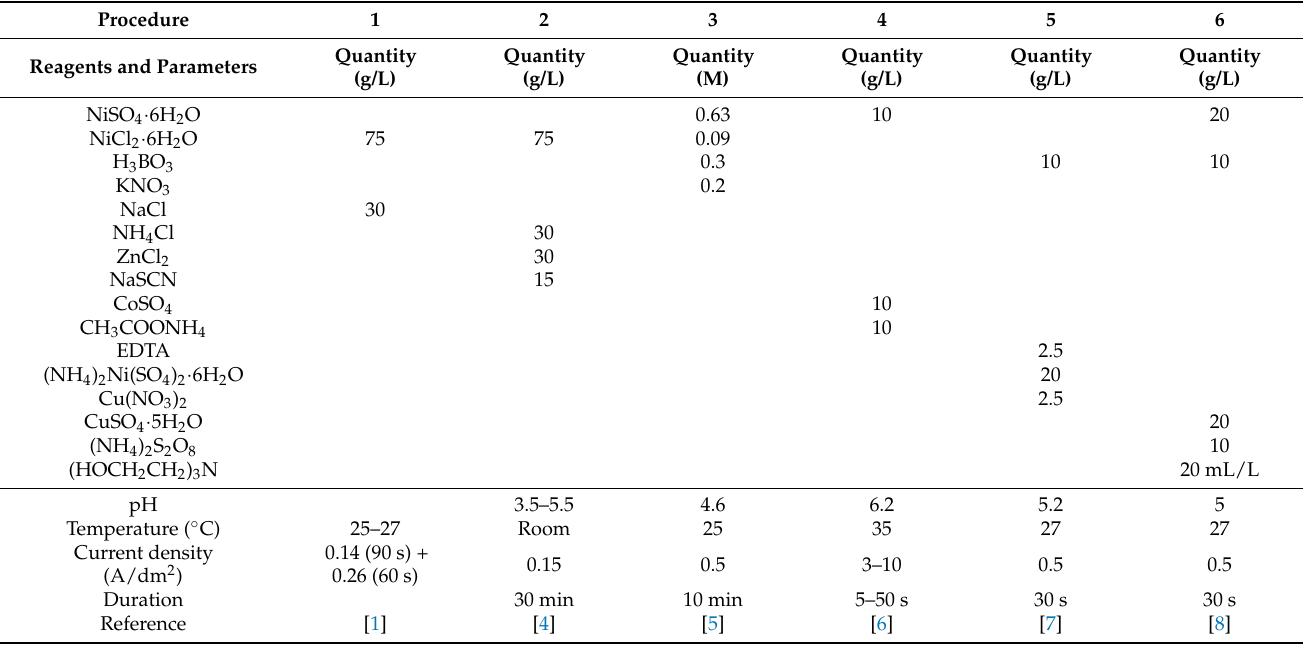
Table 1. Deposition baths and experimental conditions for producing black nickel coatings (adapted from [9]).